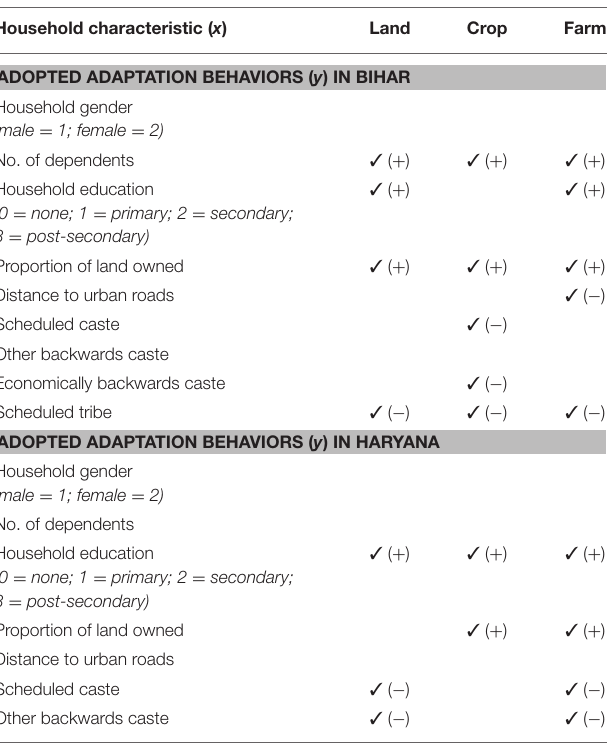
TABLE 4 | Instances where household capital fully mediates (indirect-only) the relationships between a given household characteristic and their adaptation behavior ( 3 = p < 0.05) in Bihar and Haryana ( ± indicates direction of the relationship).